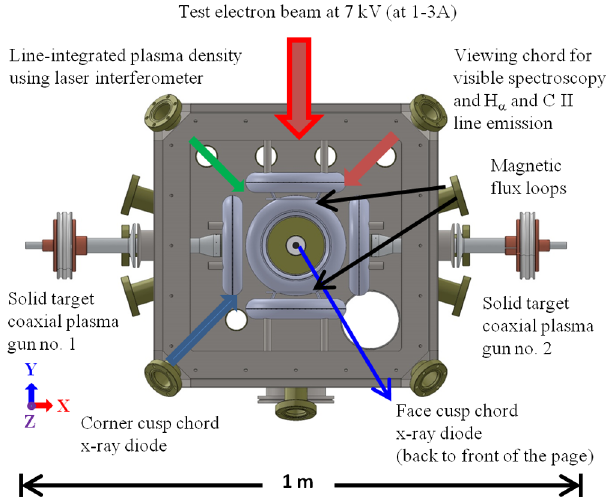
FIG. 2. Experimental setup of high- β plasma confinement study using hexahedral cusp